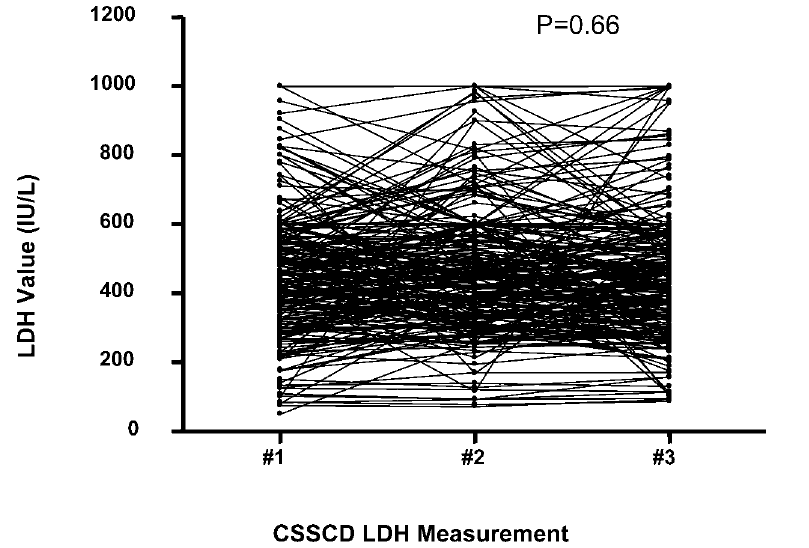
Figure 3. Stability of steady state LDH values from the CSSCD. The stability of steady state hemolytic rate is demonstrated by analysis of 3 serial LDH measurements in 225 CSSCD subjects (repeated measures of ANOVA, P=0.66).